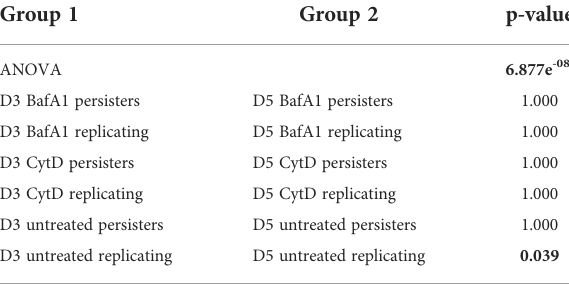
TABLE 4 Comparison of bacterial numbers between days 3 and